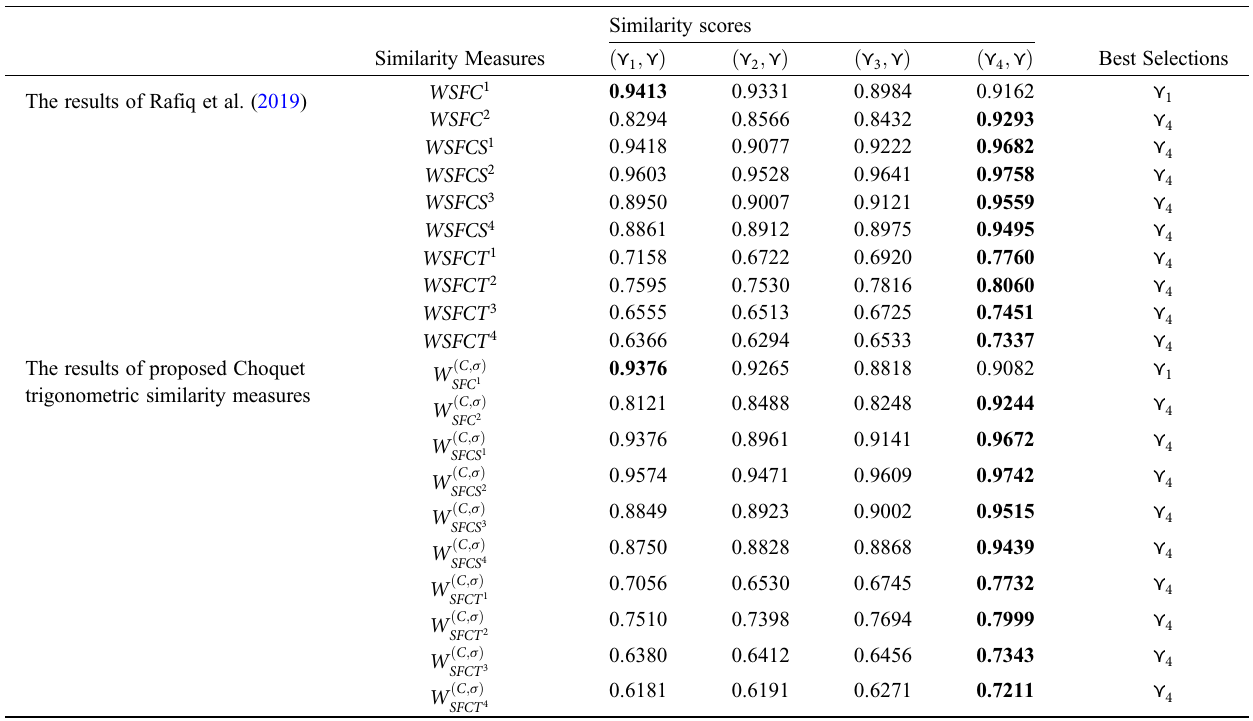
*Bold values indicate the maximum of the corresponding